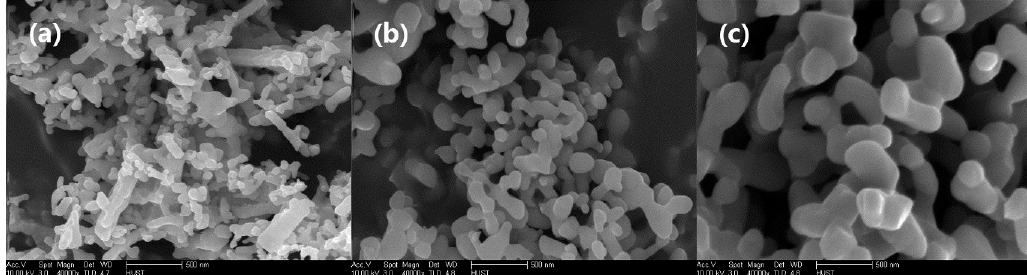
Figure 3. SEM micrograph of the CCTO powder calcined at different temperatures: ( a ) 750 °C, ( b ) 800 °C and ( c ) 850 °C.